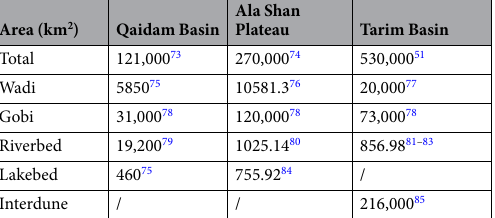
Table 2. Areas of the Qaidam Basin, Ala Shan Plateau, and Tarim Basin and areas of landscapes with potential modern dust aerosol emission in the region. Note: “/”: At present there are only a few lakebeds and interdunes developed in the Tarim Basin, Qaidam Basin and Ala Shan Plateau. Therefore, their areas are